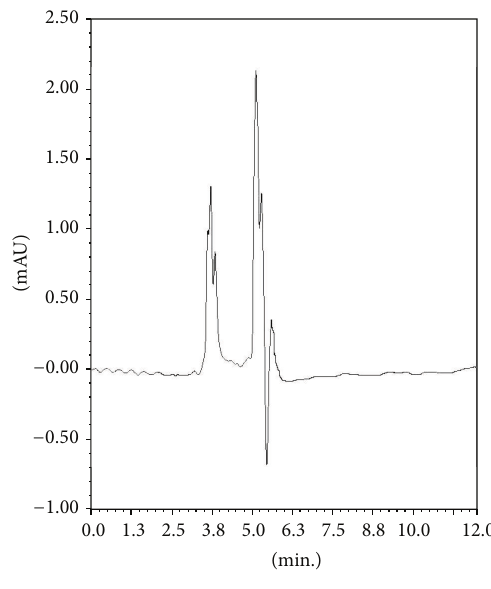
Figure 3: Chromatogram of blank